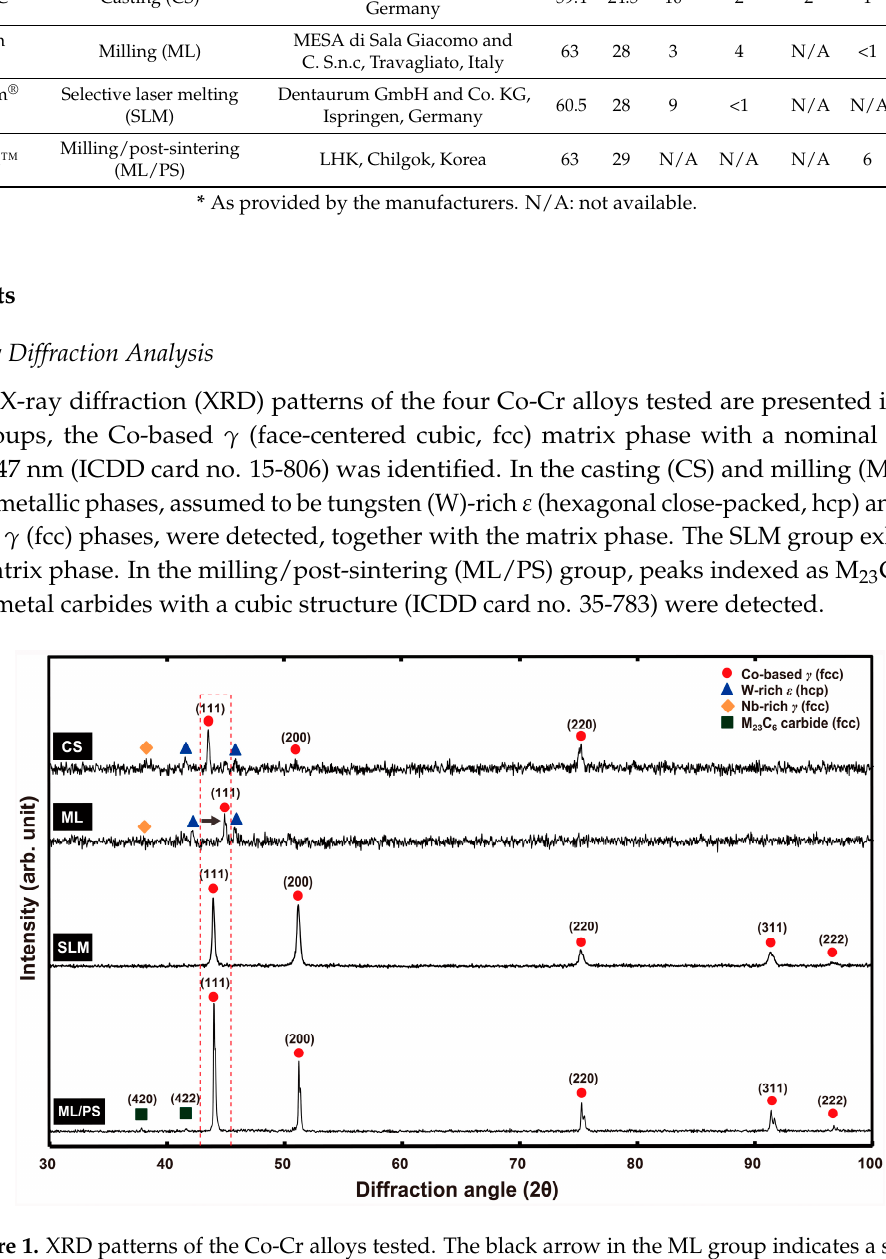
Figure 1. XRD patterns of the Co-Cr alloys tested. The black arrow in the ML group indicates a shift of the (111) plane. The SLM group showed only the presence of the Co-based γ (fcc) phase. The carbide (M 23 C 6 ) formation was identified only in the ML/PS group.